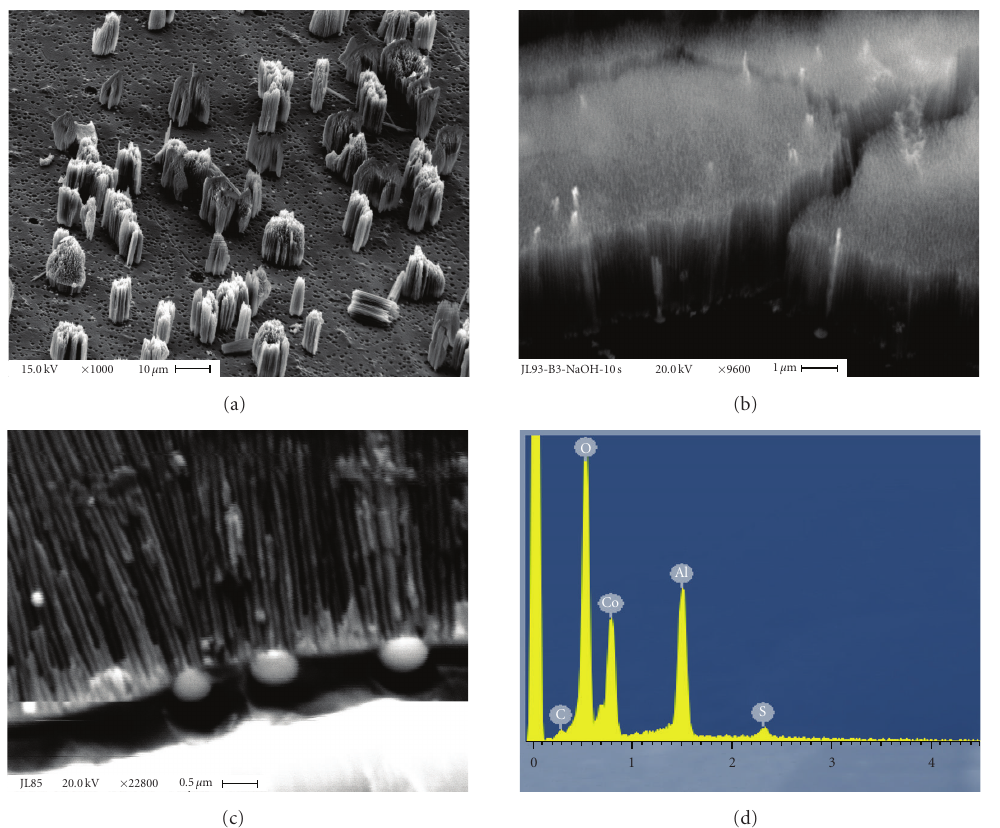
Figure 6: SEM images of reconstructed oxalic acid alumina templates after deposition of Co nws by AC treatment in the solution as in Figure 1 at U p − p 32 V and room temperature for 20 minutes. h AAO 13 μ m, Ø pore ∼ 45nm, τ w 30 minutes in 0.5 M H 3 PO 4 . (a) top-side view after dissolution some part of alumina; (b) in plane view; (c) cross-sectional view. (d) EDX spectrum of